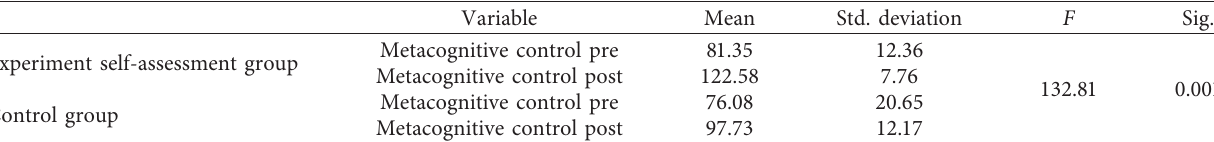
Table 3: Results of covariance analysis for the metacognitive control variable of self-assessment